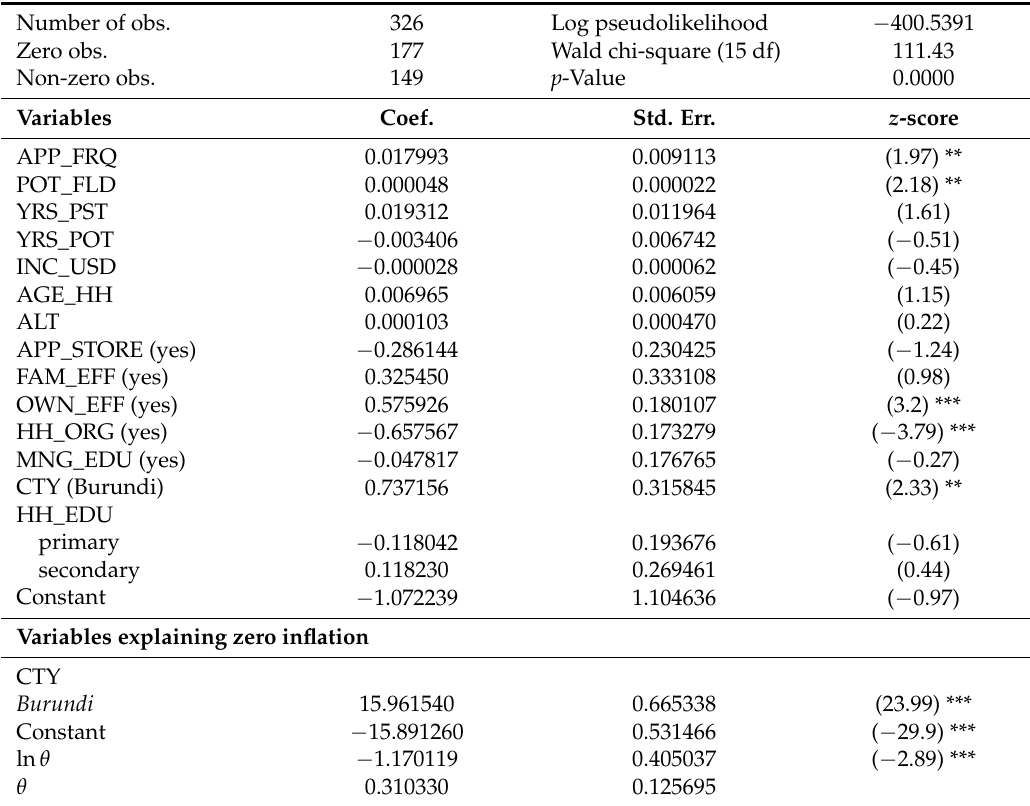
Table 3. Summary results of the zero-inflated negative binomial model (ZINB) model and the influence of the different variables on the number of PPEs used. Number of obs. 326 Log pseudolikelihood − 400.5391 Zero obs. Non-zero